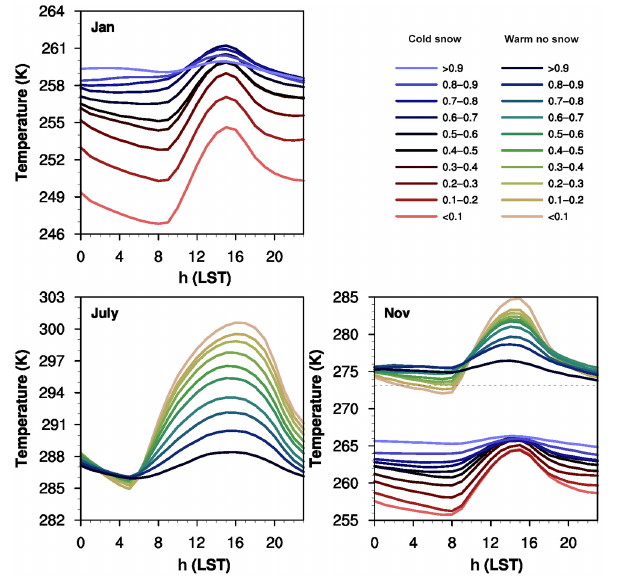
Figure 4. Diurnal cycle of temperature stratified by opaque cloud for January, July and November (adapted from Betts and Tawfik,